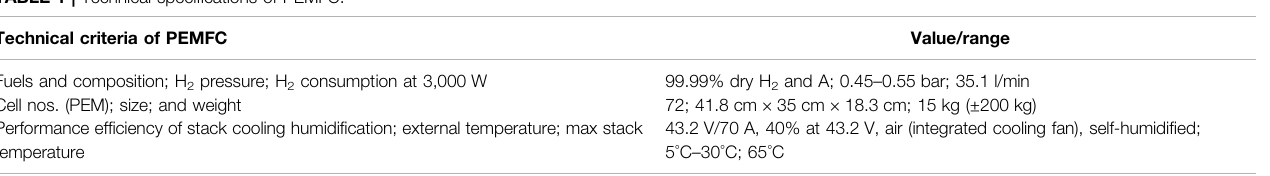
TABLE 1 | Technical speci fi cations of PEMFC.